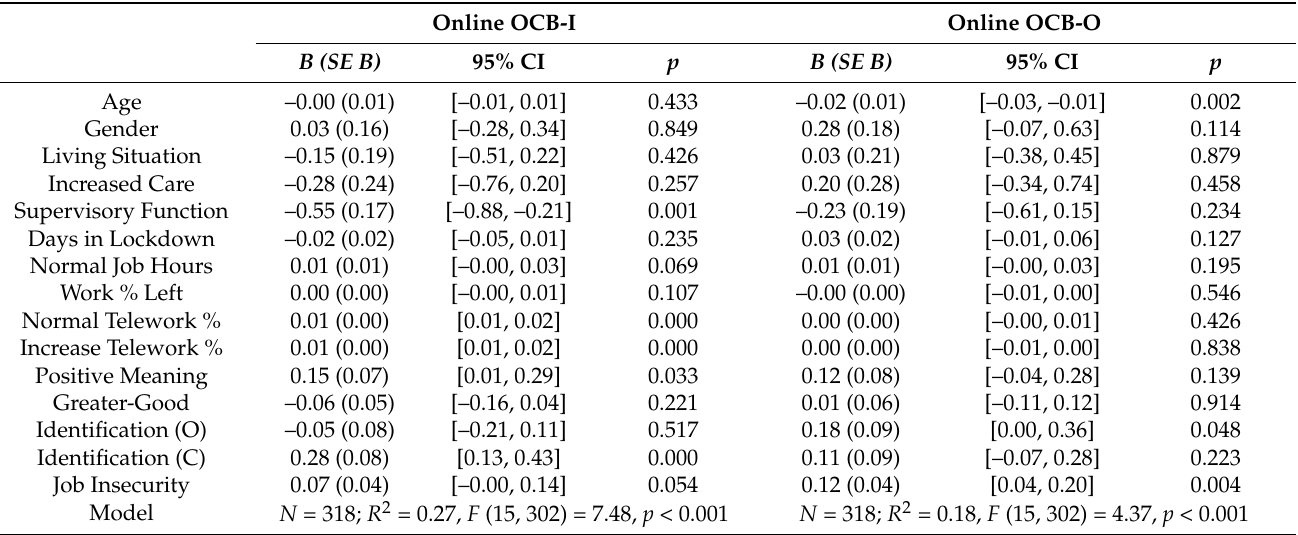
Table 7. Multiple regressions of work perceptions on online OCB-I and online OCB-O.